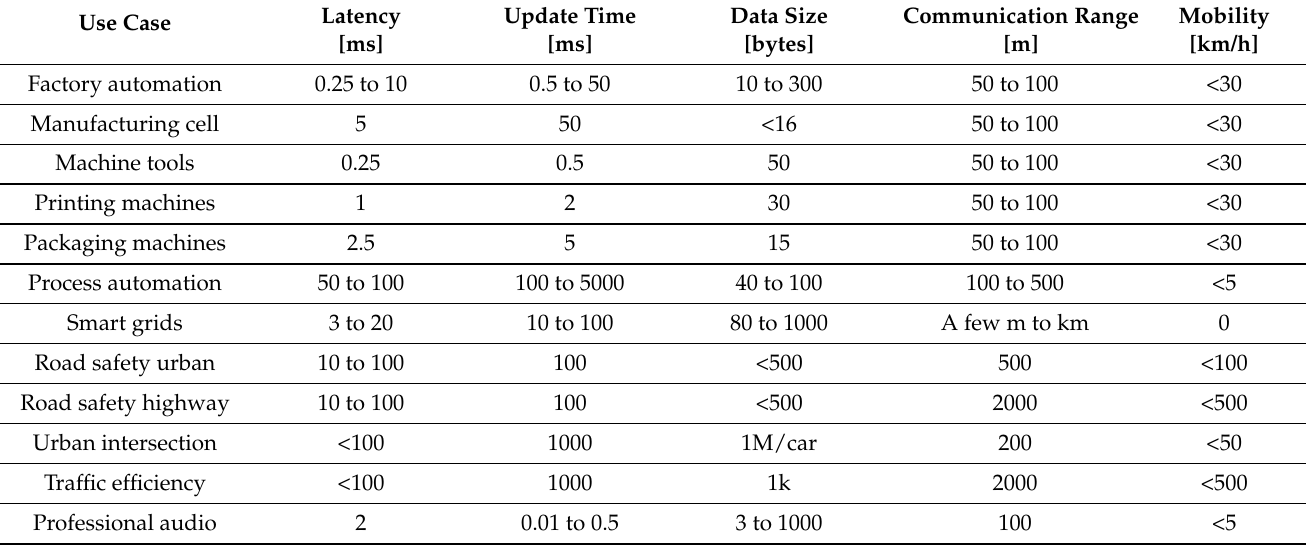
Table 1. Communication requirements of latency critical IoT applications